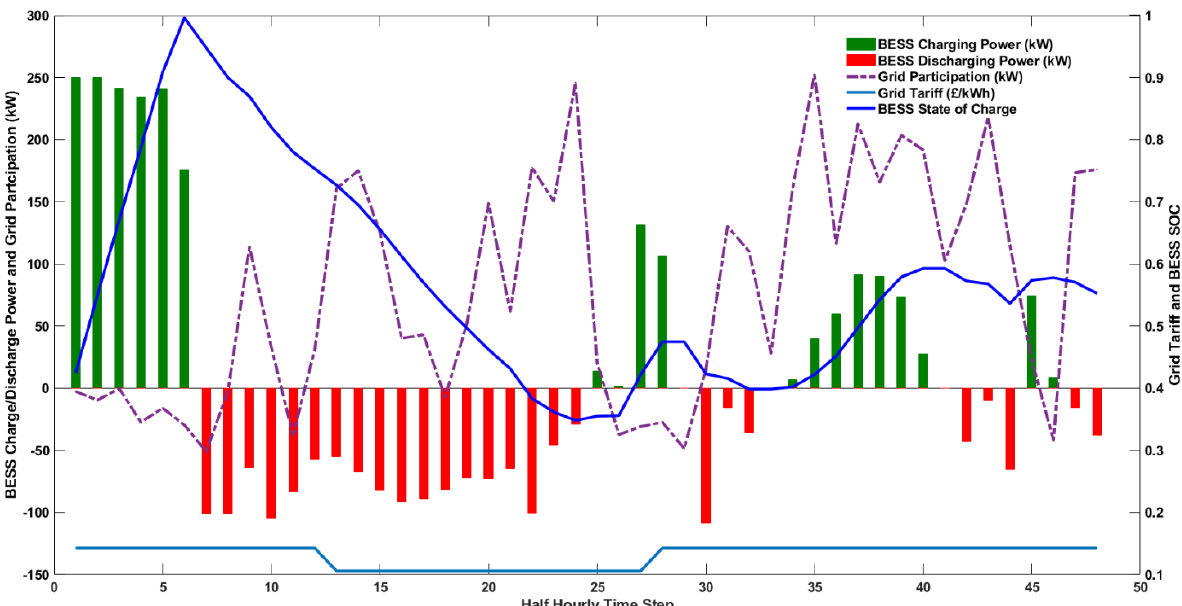
Figure 10. Total electrical power generated, real-time load demand, and BESS charge/discharge command (Scenario 2).